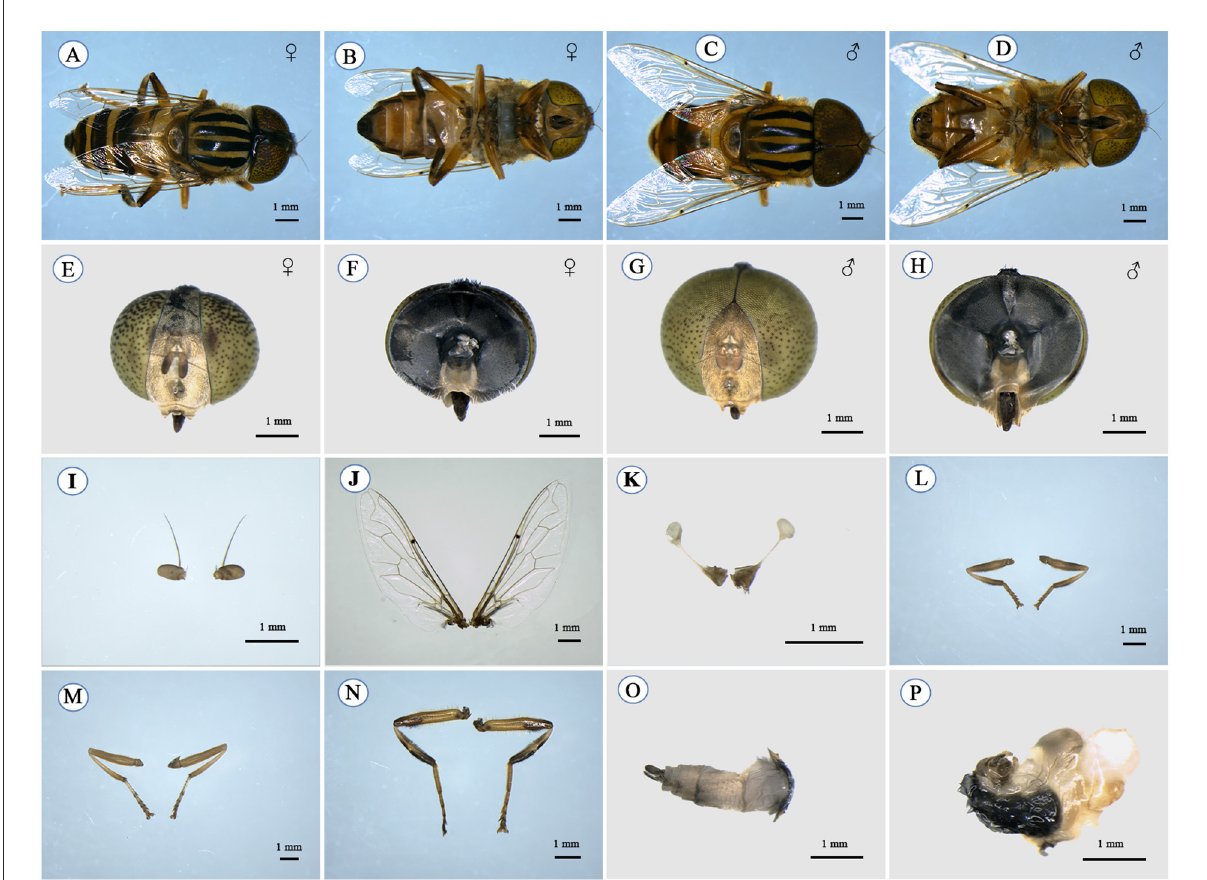
FIGURE5 Adult of Eristalinus arvorum : female: (A) dorsal view, (B) ventral view, (E) prosoma frontal view, and (F) prosoma dorsal view; male: (C) dorsal view, (D) ventral view, (G) prosoma frontal view, (H) prosoma dorsal view, (I) antennae, (J) wing membrane, (K) halter, (L) foreleg, (M) midleg, (N) hindleg, (O) ovipositor and gonostylus, and (P) gonosaccus and gonostylus.